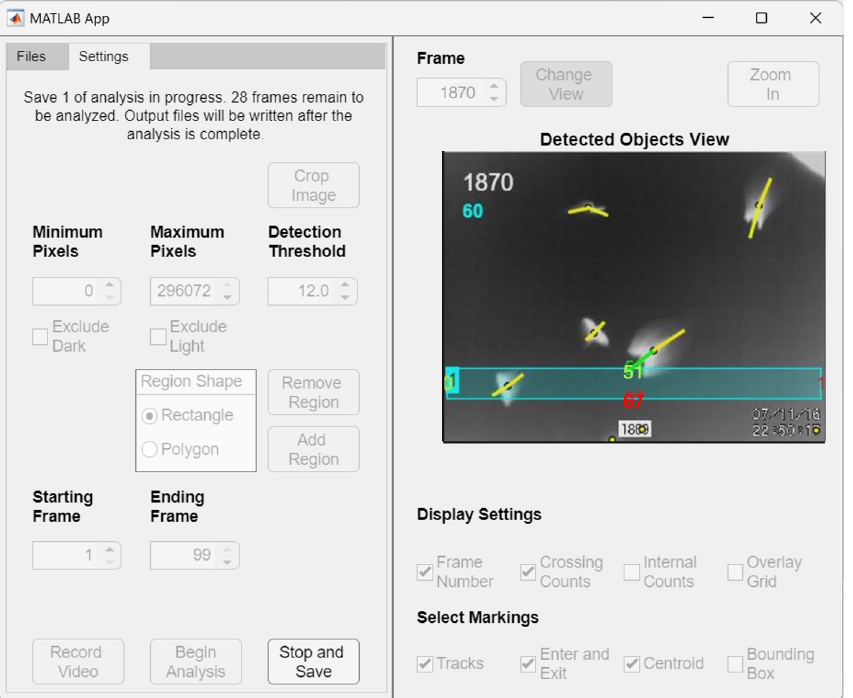
Fig 1. BatCount user interface with a video loaded and the detected object’s view toggled on. This image was taken during an analysis of a video, so many of the adjustable user parameters appear grayed out and not editable at this stage. A rectangular region of interest has been specified on this frame to count the number of bats that pass through it. The bats’ overall flight trajectory starts from the top of the image and continues toward the bottom portion of the screen, intersecting the rectangular region along their path. The frame number 1870 is shown in white, and the crossing sum (60 in this case), which calculates the bats that move through the rectangular region, is displayed below it. A net count of 51 bats have entered the top of the region (shown in green), 67 have left the bottom of the region (shown in red), one net bat has exited the right (shown in red) and no net bats have exited the left side (note the blue highlighted 1, which indicates the number of the selection box, slightly obscures the yellow 0 below). See S1 Video for the original video file used for this analysis, S1 Table for corresponding summary output table and S2 Video for the software output video file. Note: for ease of visibility in the manuscript we electronically manipulated the contrast of the box counting numbers due to partial occlusion by the box and tracking line.